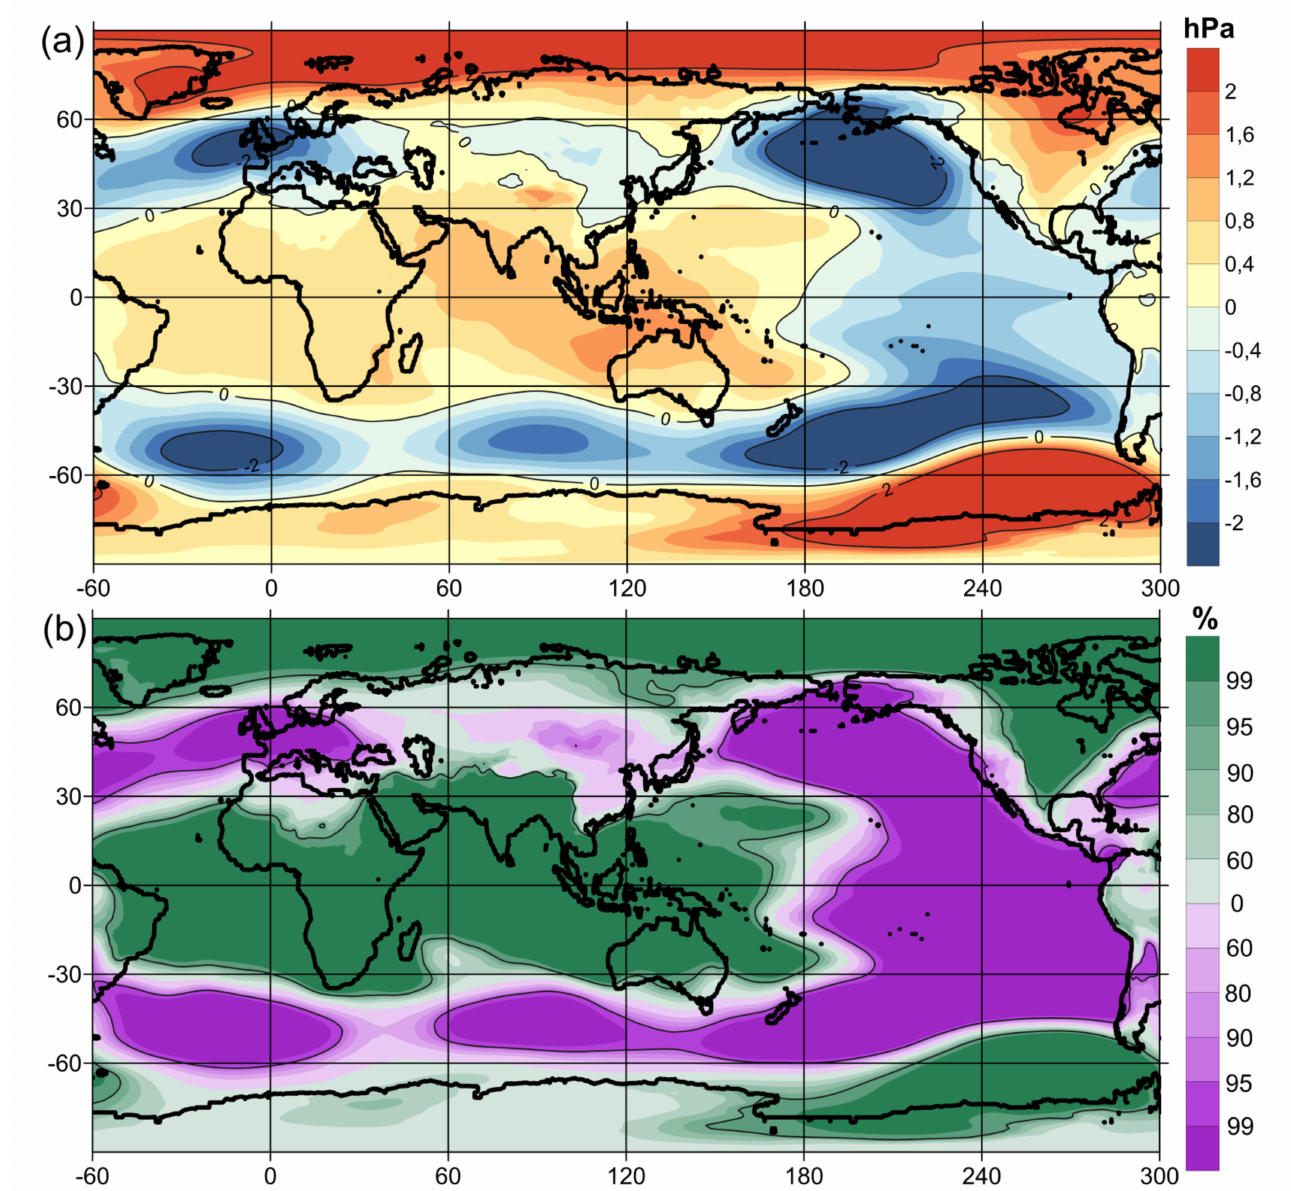
Figure 4. The difference in average atmospheric sea-level pressure anomalies between the opposite phases of the Global Atmospheric Oscillation by GAO2 index ( a ). The probability values for ( a ) according to Student’s t -test ( b